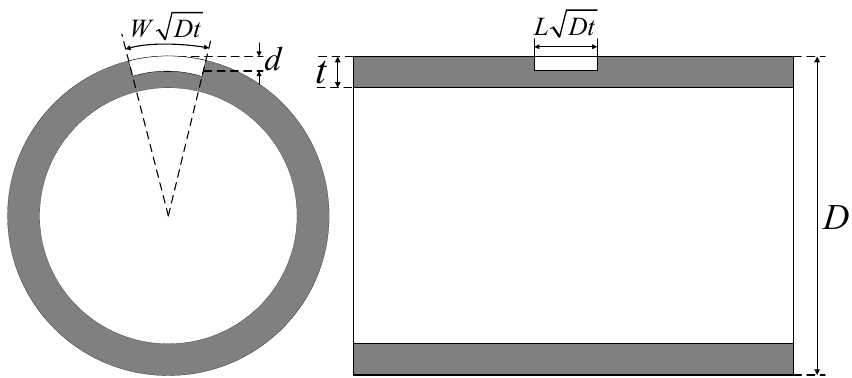
Figure 9. Schematic diagram of external corrosion defect.